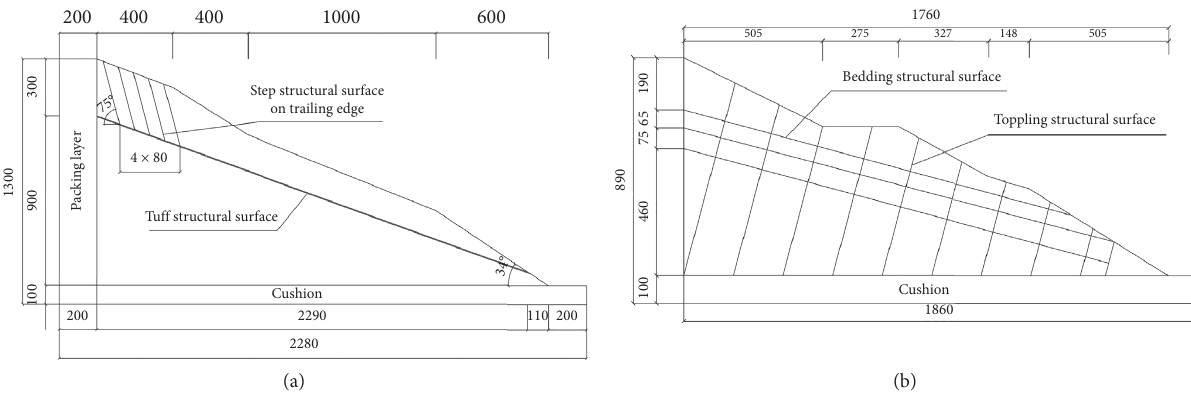
Figure 9: Design of the slope model (unit: mm): (a) Huaping slope; (b) Lijiang